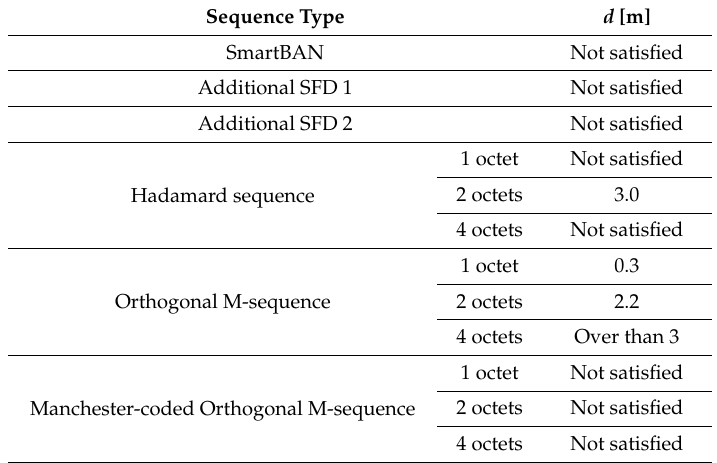
Table 8. Communication distance when failure detection ratio satisfies 10 − 2 or less under IEEE model